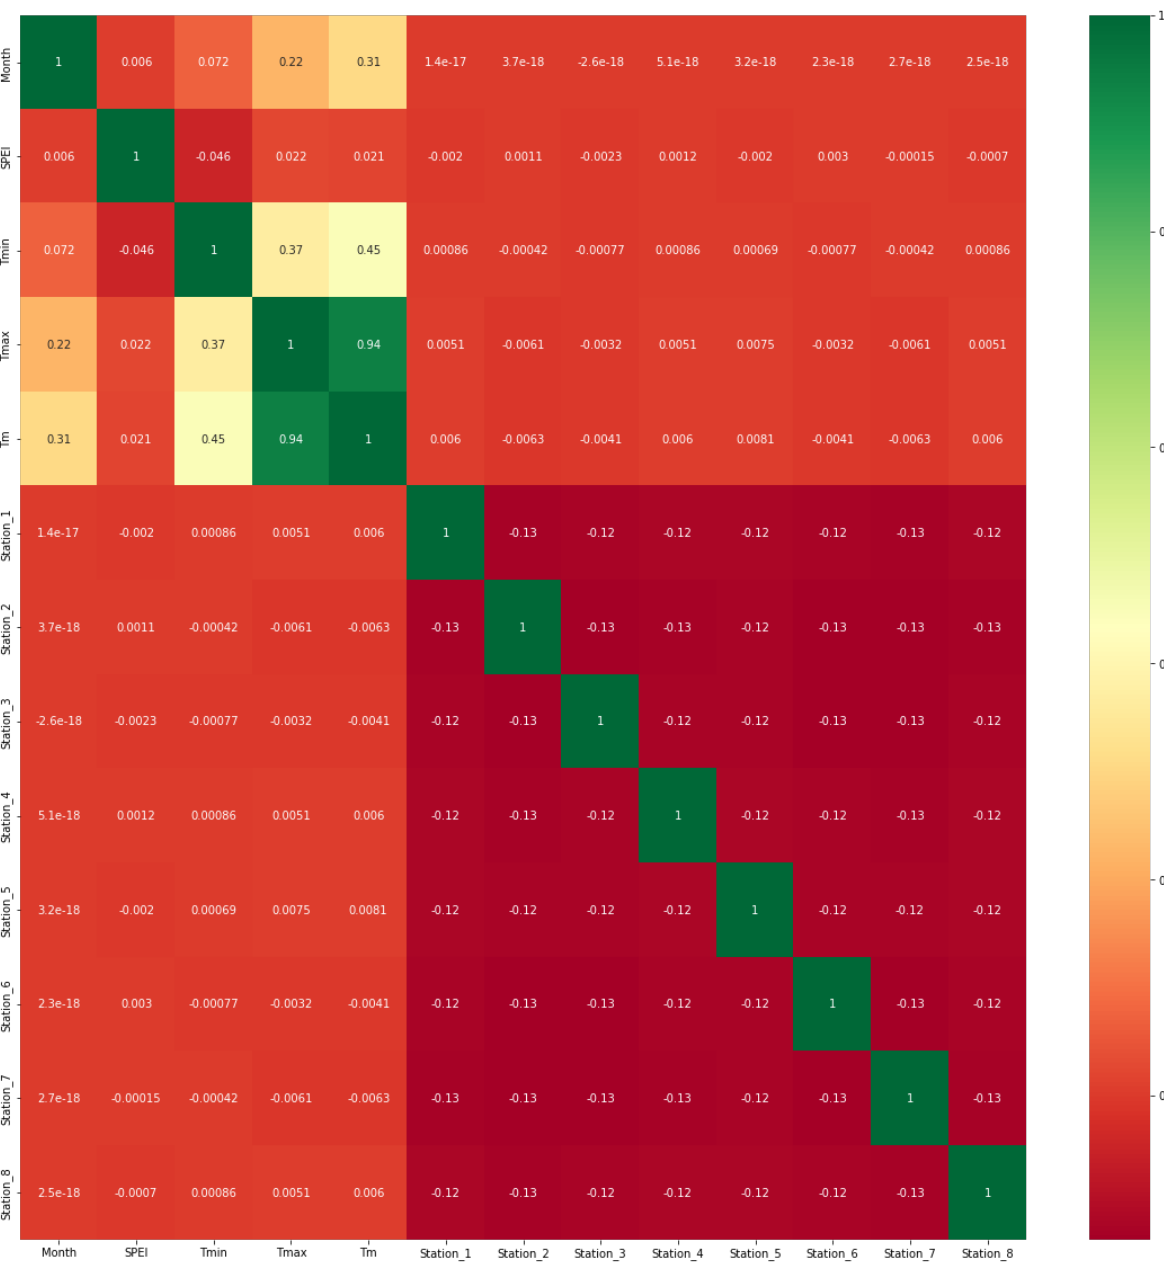
Figure 6. Correlation matrix of input data.